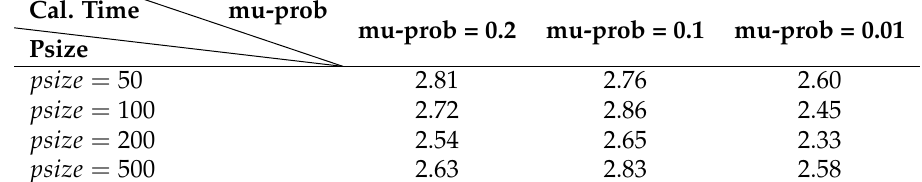
Table 4. Genetic algorithm (GA) for SML estimation with different parameters where crossover probability is 0.5, p = 8, q = 2, r = 2, N = 100, SNR = 5 dB, 30 independent trials, RMSE = 0.26. PsizeCal.